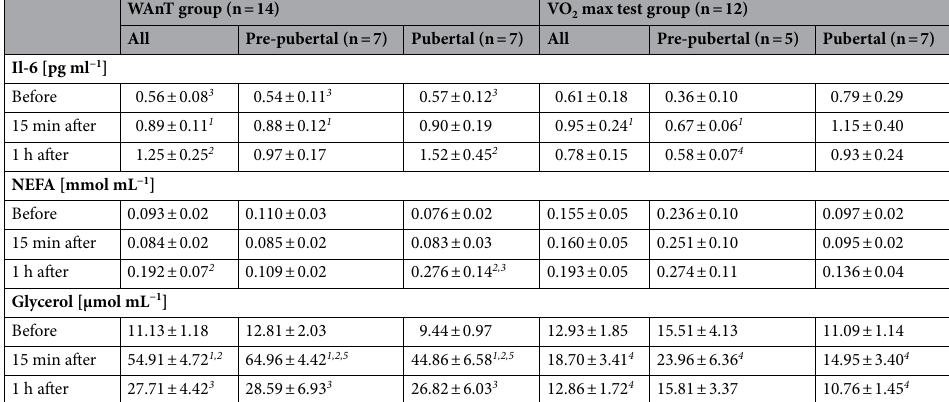
WAnT group (n = 14) VO 2 max test group (n = 12) All Pre-pubertal (n = 7) Pubertal (n = 7) All Pre-pubertal (n = 5) Pubertal (n =